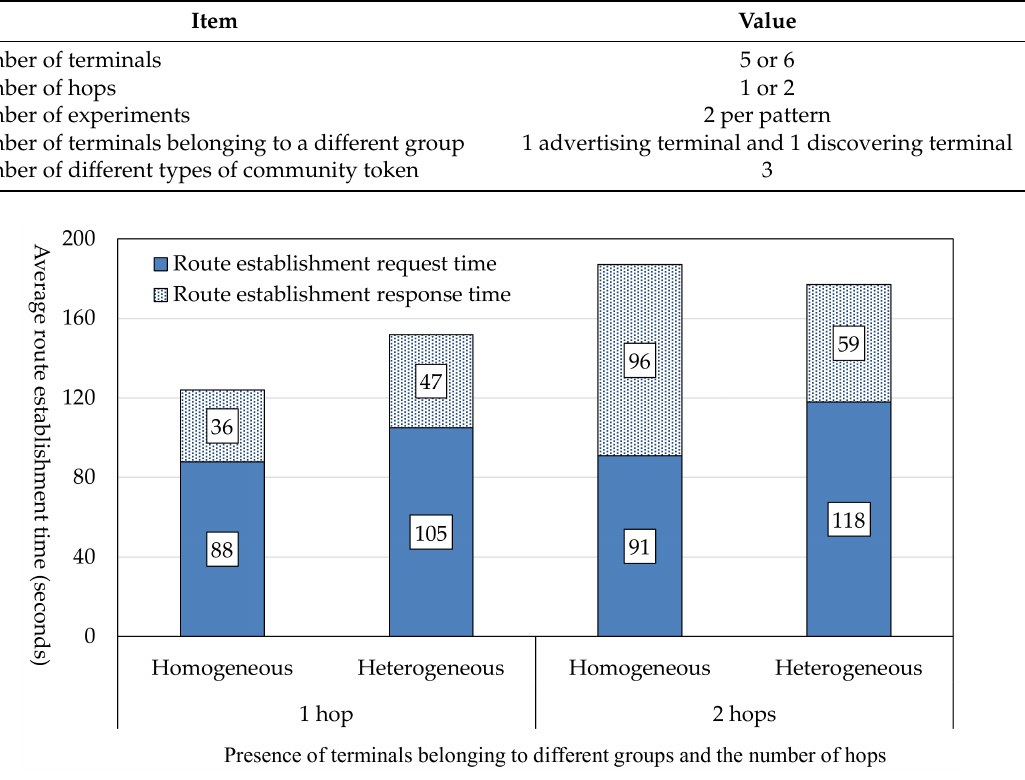
Figure 12. Route establishment time when there are terminals belonging to different groups.